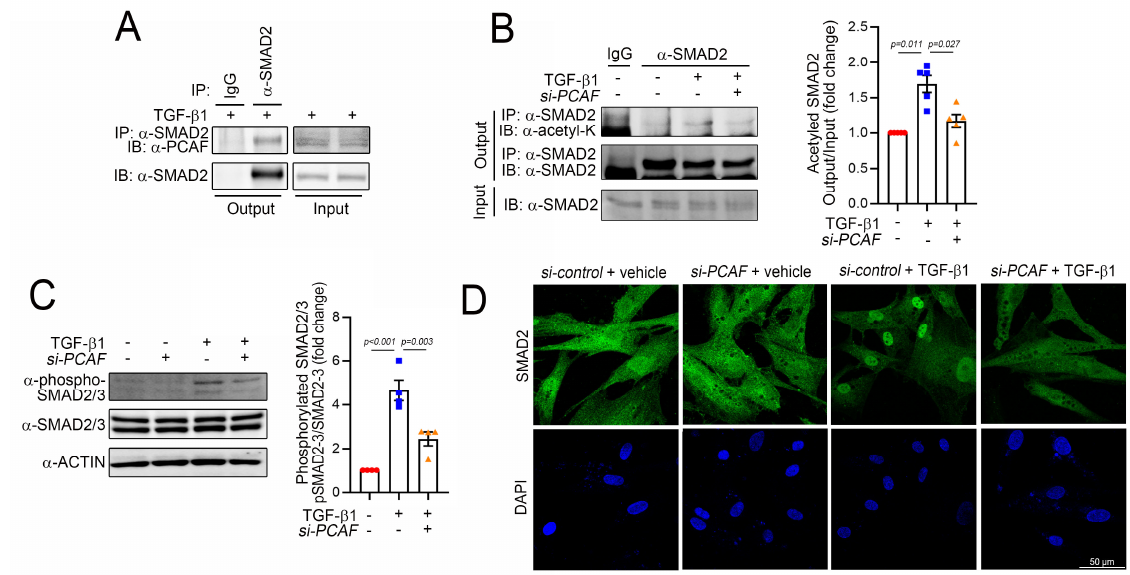
Figure 5. PCAF acetylates and activates SMAD2 in human cardiac fibroblasts. ( A ) Immunoprecipitation assay to show the interaction between SMAD2 and the PCAF. The endogenous SMAD2 precipitated the endogenous PCAF. ( B ) Immunoprecipitation-based acetylation assay. The TGF- β 1-induced acetylation of SMAD2 was significantly attenuated by PCAF siRNA . Quantification results are shown in the graph on the right. ( C ) Phosphorylation of SMAD2/3 and its quantification results. ( D ) Fluorescent immunocytochemistry for SMAD2. TGF- β 1 induced the nuclear localization of SMAD2, which was blocked by PCAF siRNA